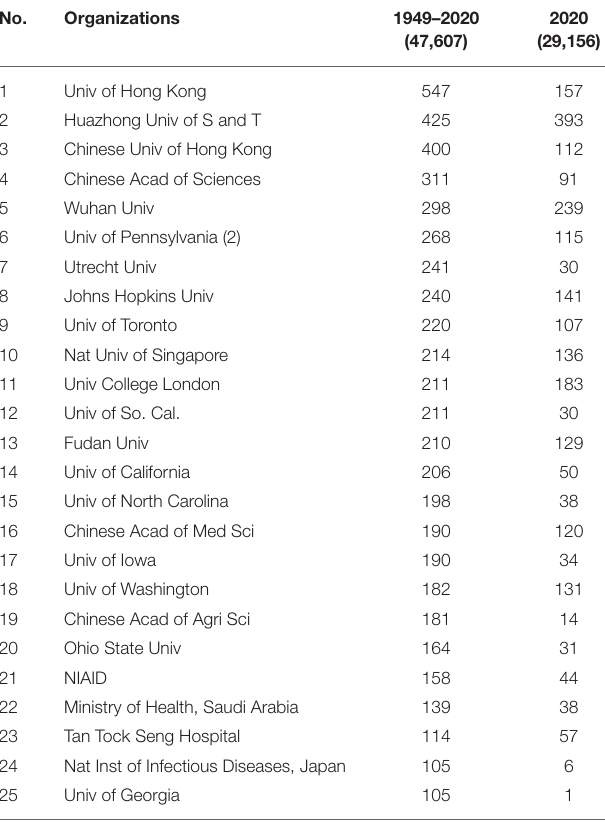
Figure 4 , as well as Supplementary Figure 3 , track